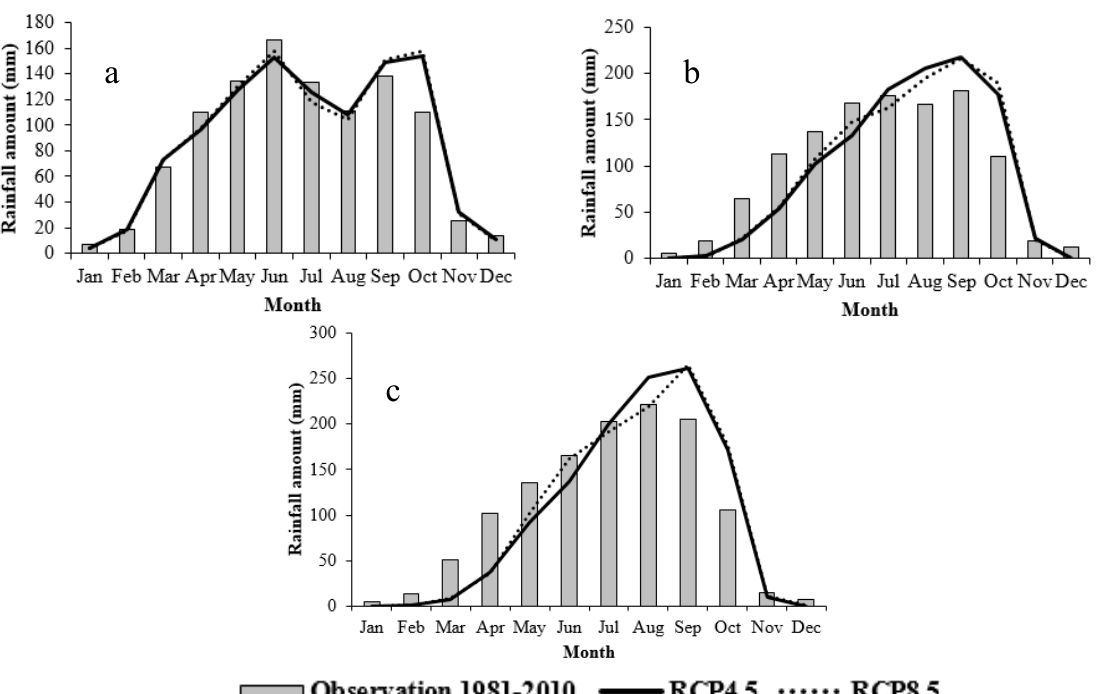
Figure 6. Seasonal cycles of rainfall in the south ( a ), center ( b ) and north ( c ) under RCP4.5 and RCP8.5.